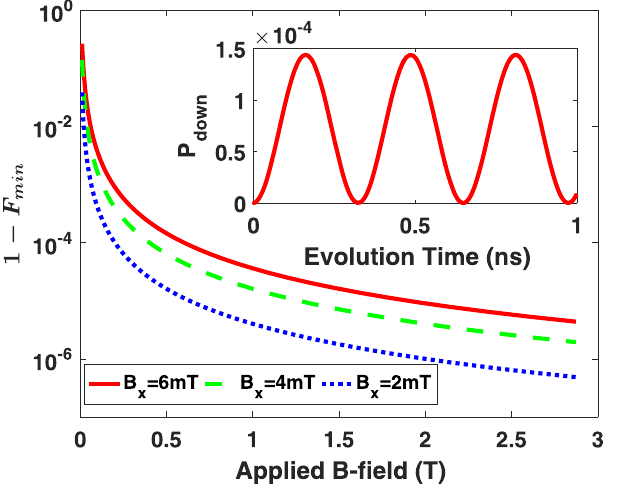
Figure 3. Spin fidelity loss caused by hyperfine interaction. The main figure shows the largest deviation from the initial state during the whole evolution. The inset is a dynamical evolution in 1 ns of the spin for the parameters B = 0.5 T, B nuc , x = 6